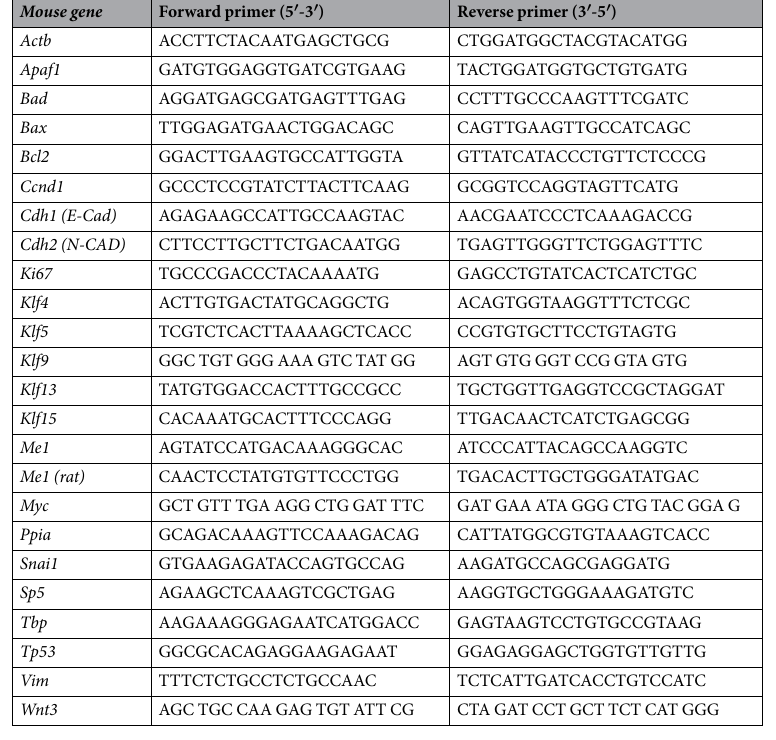
Table 1. DNA primers used in qRT-PCR of mouse